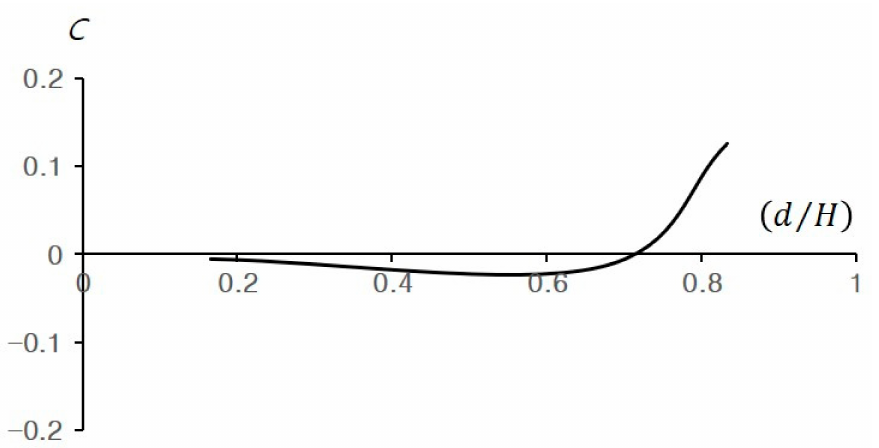
Figure 10. Course stability index by ship-draft to water-depth ratio.